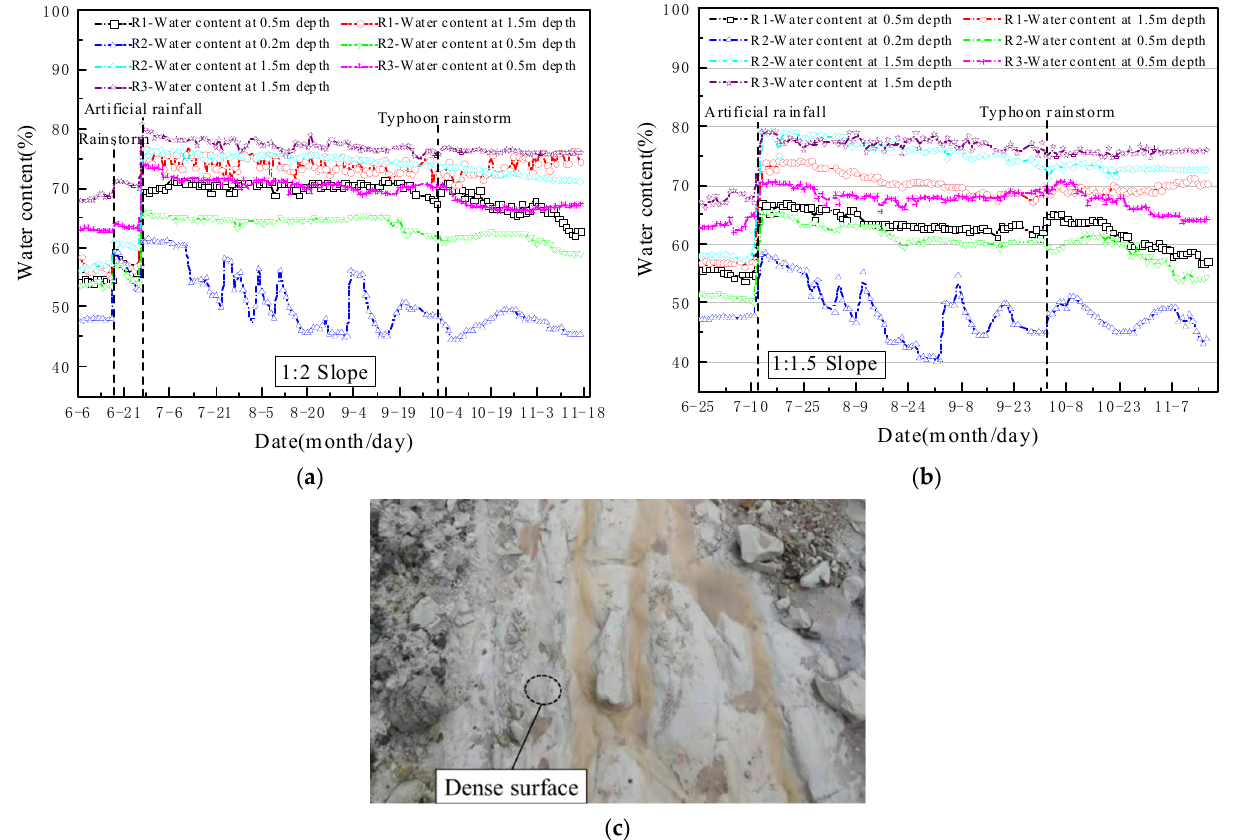
Figure 9. Water content analysis: ( a ) 1:2 natural slope water content variation trend; ( b ) 1:1.5 natural slope water content variation trend; ( c ) excavation of the diatomaceous earth slope.